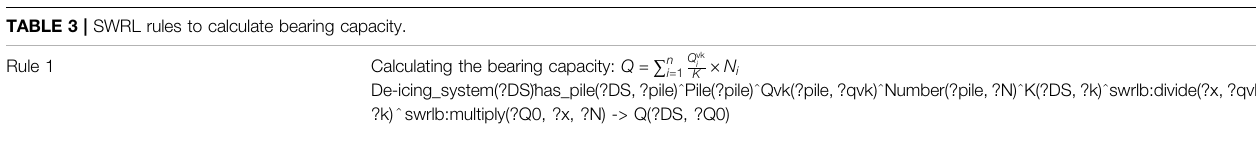
TABLE 3 | SWRL rules to calculate bearing